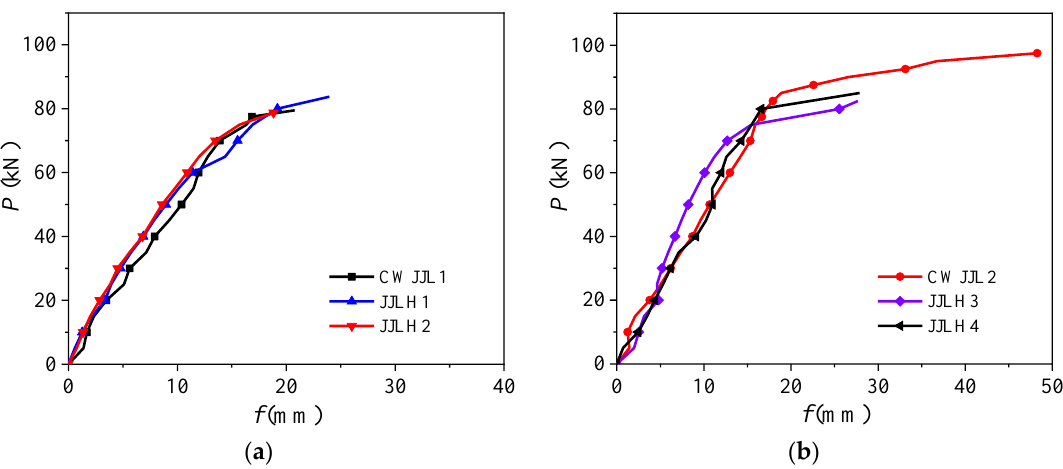
Figure 10. Load − vertical displacement curves of the beams under indirect loading: ( a ) shear failure beams and ( b ) flexural failure beams.